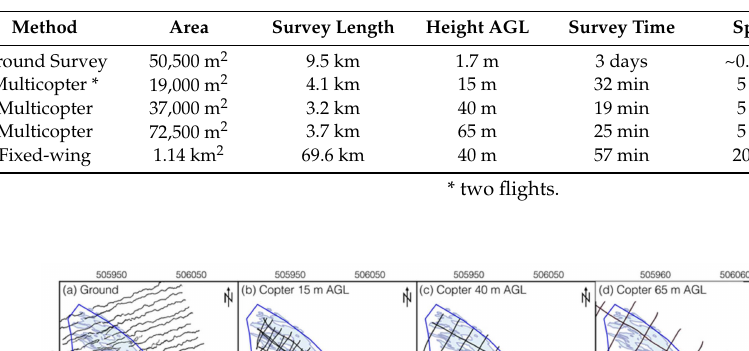
Table 5. Parameters of the magnetic surveys. Survey time includes take-o ff and landing.